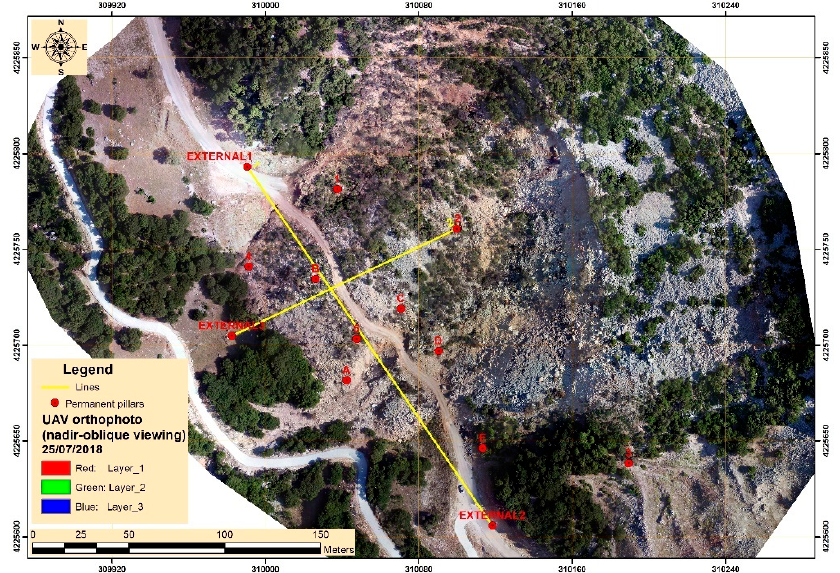
Figure 6. Orthophotos of the study area. ( a ) Orthophoto from a combination of nadir and oblique imagery on 5 November 2017. ( b ) Orthophoto from nadir imagery on 5 November 2017. ( c ) Ortho- photo from oblique imagery on 5 November 2017.